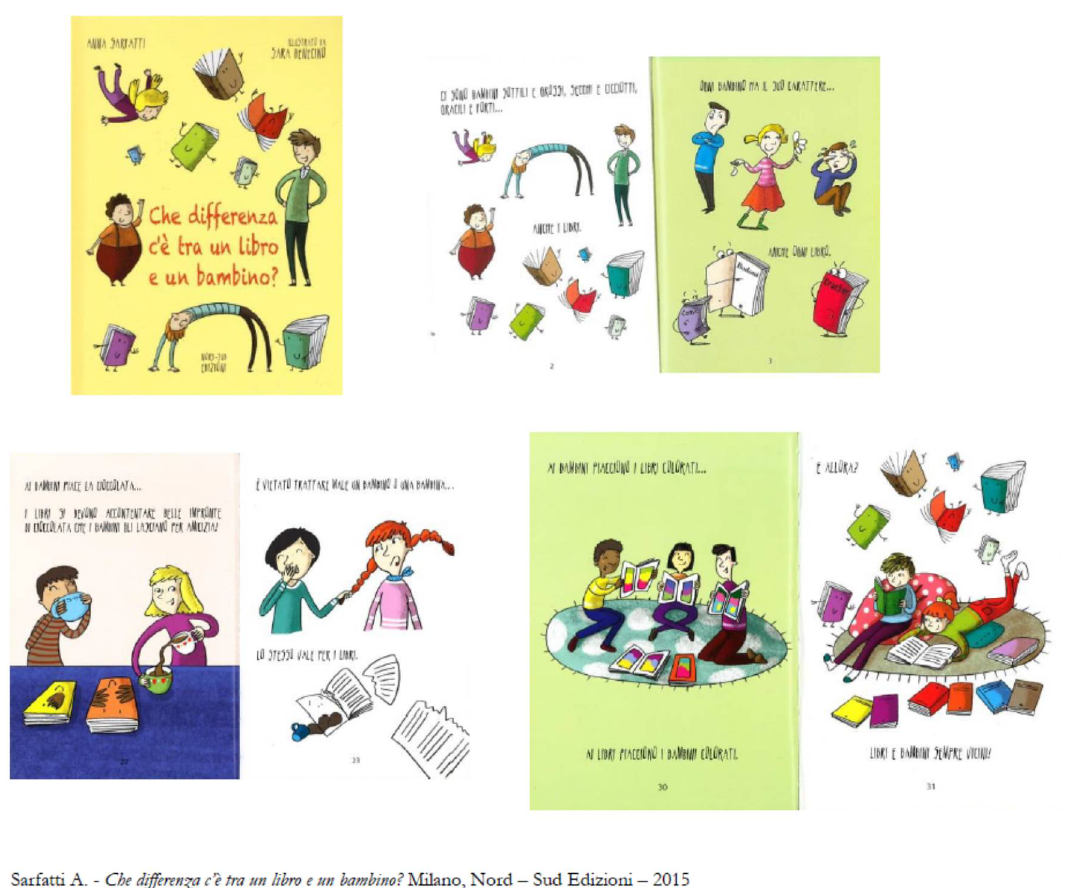
Figure A6. Sarfatti A.— Che differenza c'è tra un libro e un bambino? Milano, Nord-Sud